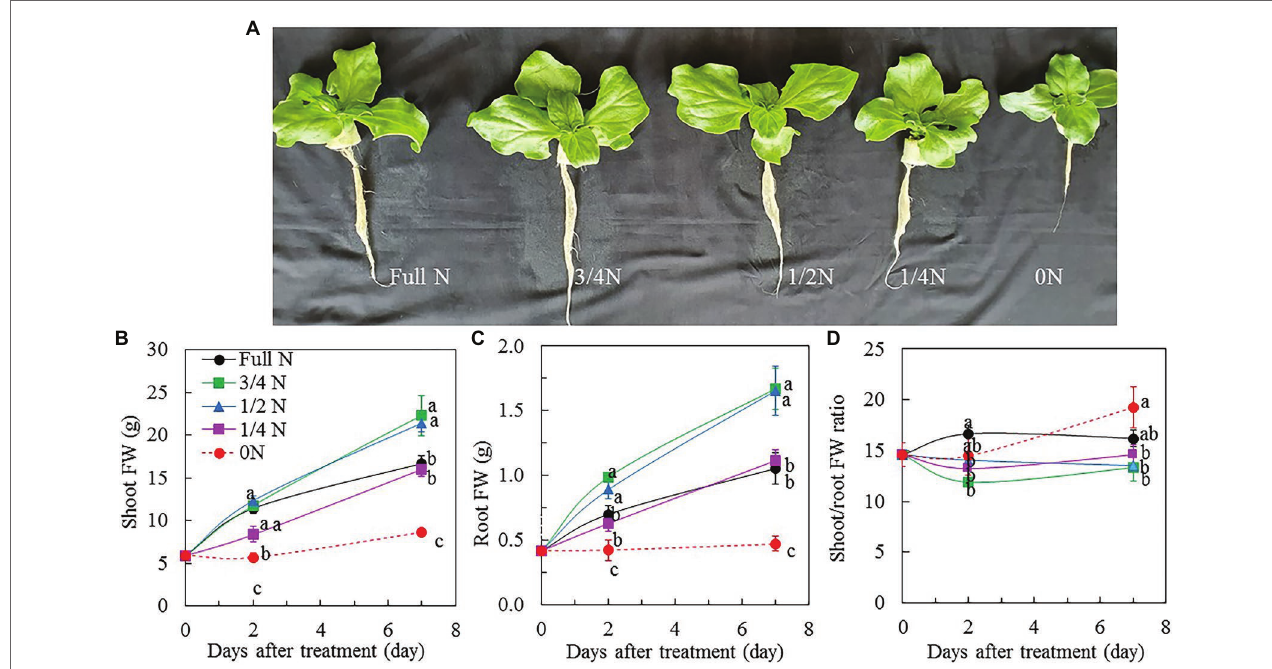
FIGURE 1 | Mesembryanthemum crystallinum grown indoor hydroponically for 18 days with different levels of NO 3– supply (A) . Changes in shoot fresh weight (FW; B ), root FW (C) , and shoot/root FW ratio (D) of M. crystallinum after different NO 3– treatments. Vertical bars represent the SEs. Means with different letters are statistically different ( p = 0.05; n = 5) as determined by LSD multiple comparison test.